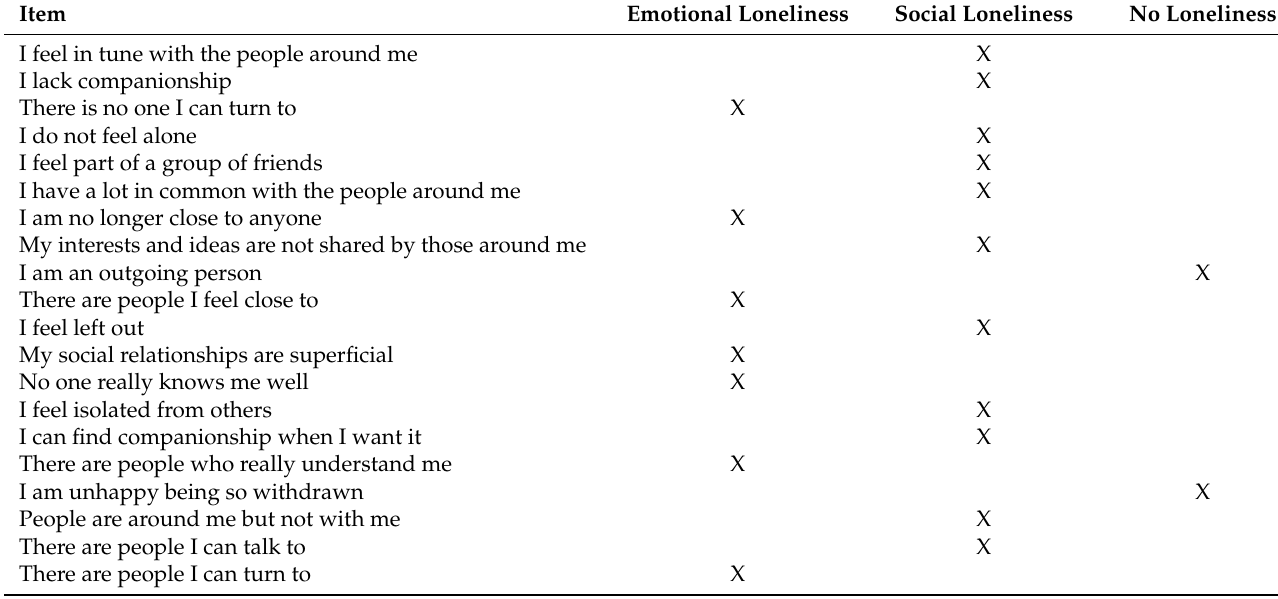
Table 1. Coding of Items of the University of California Los Angeles Loneliness Scale